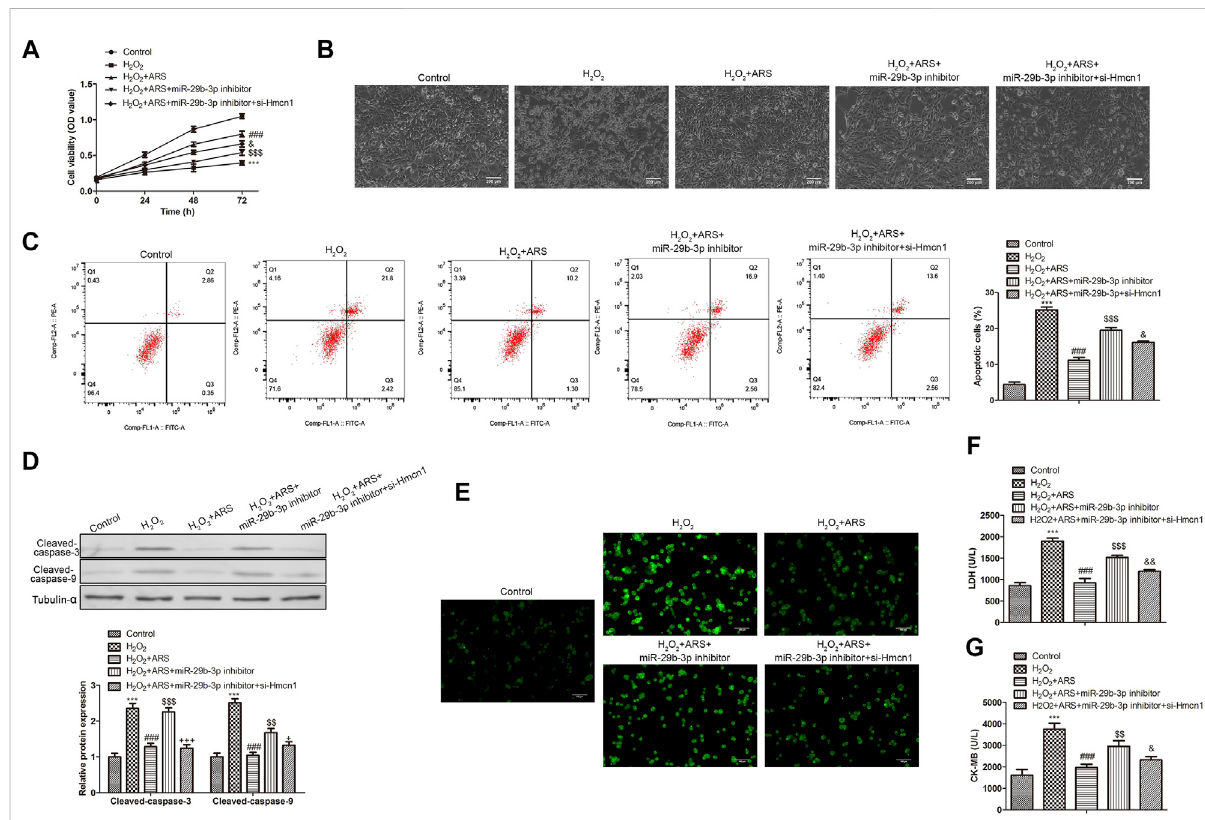
FIGURE 5 ARS suppresses myocardial I/R injury through regulating MiR-29b-3p/HMCN1. Proliferation, morphological changes, apoptosis, apoptosis- related protein and oxidative stress biomarker of H9c2 cells observed via (A) CCK-8, (B) inverted phase contrast microscope (200 μ m), (C) Flow cytometry, (D) Western blotting, (E) DCFH-DA (100 μ m), (F) LDH Cytotoxicity Assay and (G) CK-MB isoenzyme assay, respectively. N = 3, *** p